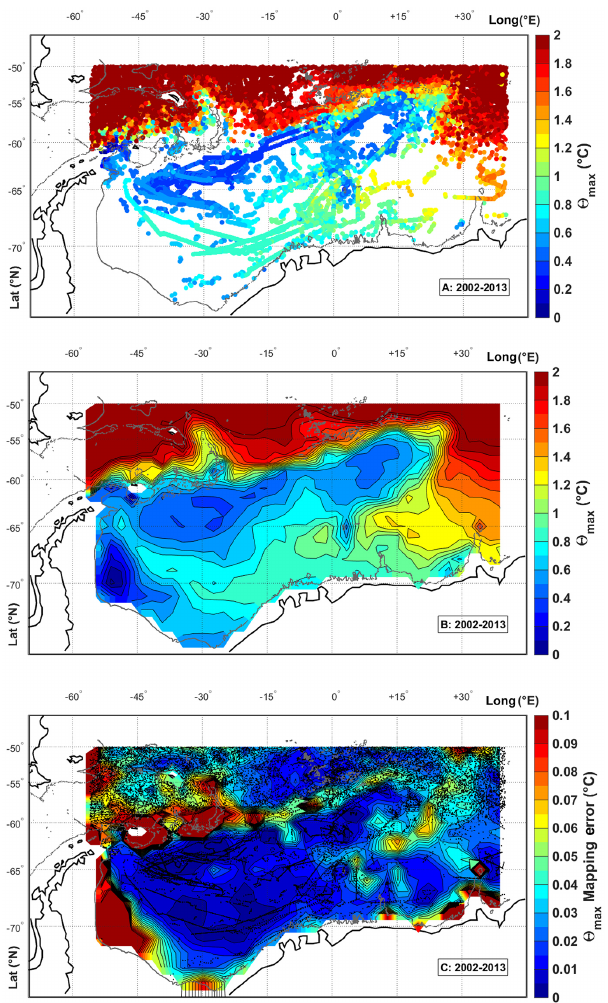
Figure 12. Pressure (dbar) at the sub-surface temperature maxi- mum for the entire time period, where panel (a) shows the orig- inal float data, panel (b) shows the objectively mapped field and panel (c) shows the mapping error for the mapped field (profile loca- tions are marked as black dots). The grey contour shows the 2000m